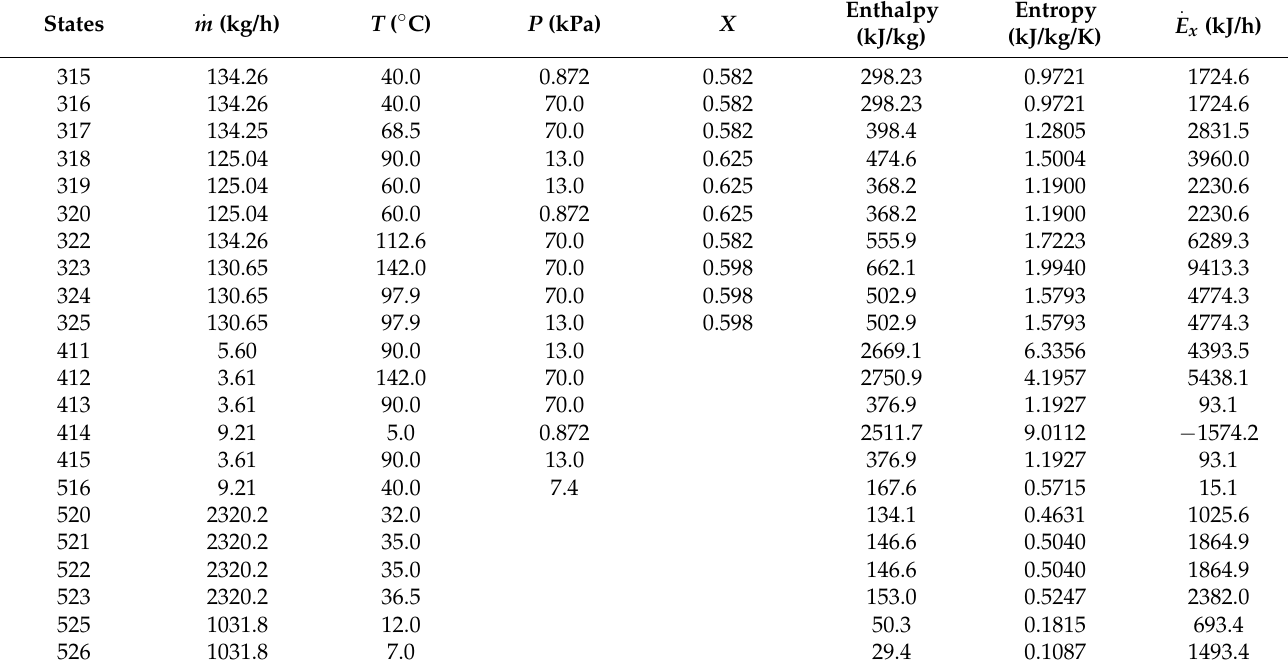
Table 6. Property values and mass and exergy flow rates at various state points in industrial double-